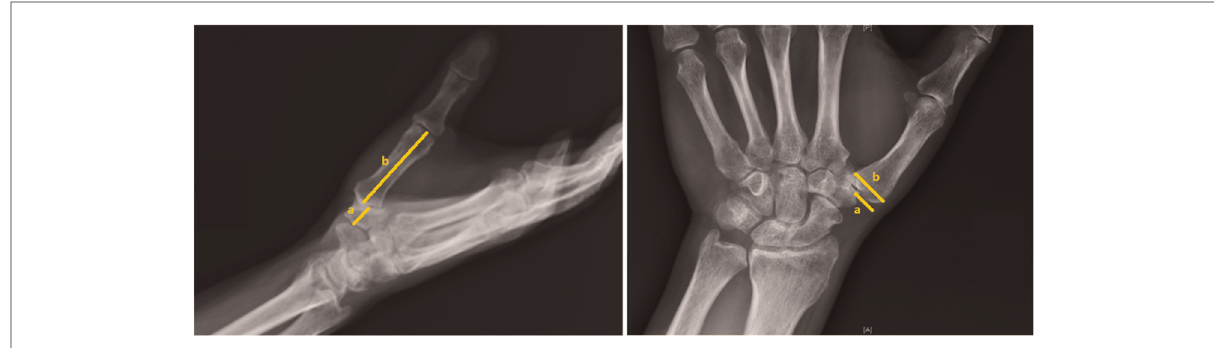
FIGURE 1 Radiograph of CMC OA with loss of joint space and radial dislocation. (Left) (a): axis of the trapezium and (b): axis of the fi rst metacarpal; (right) (a): uncovered length of trapezium and (b): total length of